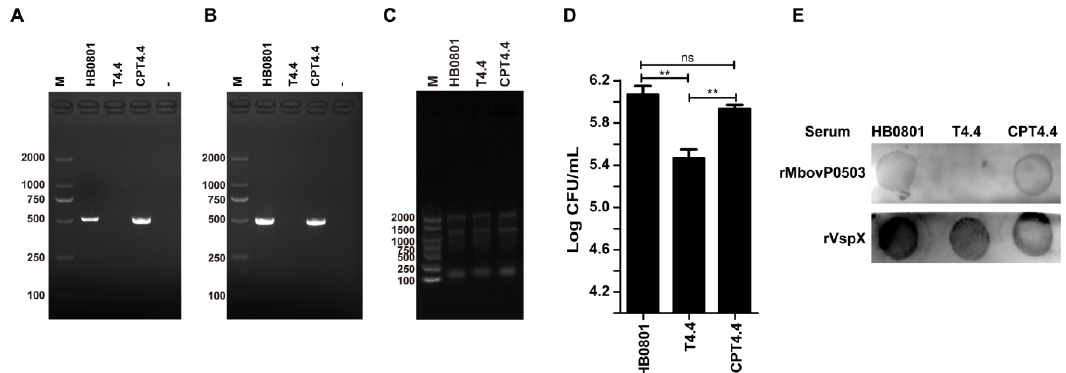
Figure 2. Complementation studies with Mbov_0503 knock-out mutant. ( A ) PCR amplification of Mbov_0503 in the parental strain (HB0801), Mbov_0503 knock-out mutant (T4.4), and complemented strain (CPT4.4), ( B ) RT-PCR amplification of Mbov_0503 transcripts, ( C ) electrophoretic analysis of total RNA, and ( D) mycoplasma binding to EBL cells. Data are the means of three independent assays. Standard deviations are indicated by error bars. P values are indicated by asterisks (** p < 0.01; ns = p > 0.05). ( E ) Immunodetection of Mbov_0503 products at the mycoplasma surface. Colonies were incubated with rMbovP0503 or rVspX antisera.